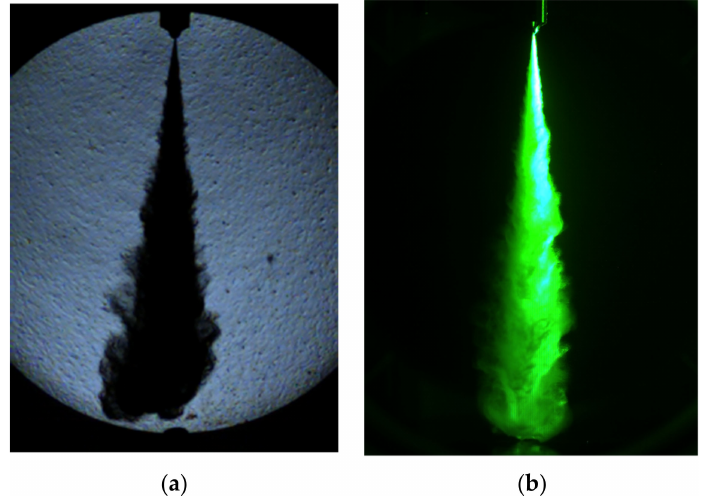
Figure 3. ( a ) An image by Schlieren photography technique, and ( b ) an image by PLIF-PIV